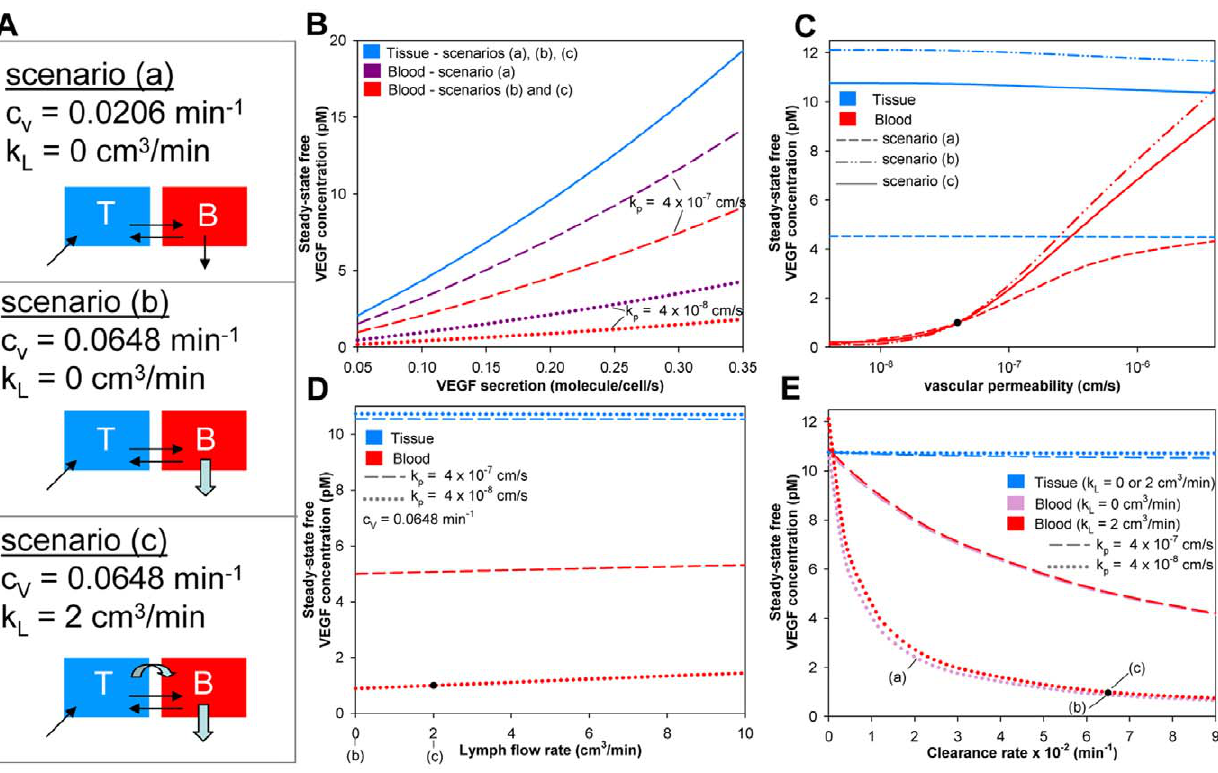
Figure 2. Effects of VEGF secretion, vascular permeability, lymph flow rate and clearance. A. Three scenarios are studied: scenario (a) our previous configuration from [9] (clearance rate c v =0.0206 min 2 1 ); scenario (b) new clearance c v =0.0648 min 2 1 in the absence of lymphatic drainage; scenario (c) introduction of the lymphatic drainage of VEGF k L =2 cm 3 /min (120 mL/hour [15]) with the new clearance c v =0.0648 min 2 1 . B. Effect of VEGF secretion. Free VEGF concentration in the tissue is illustrated in blue. The purple curve corresponds to scenario (a) and the red curves to scenarios (b) and (c) for the plasma VEGF concentration. We consider two permeability rates k p =4 6 10 2 8 cm/s (dotted curve) and 4 6 10 2 7 cm/s (dashed curve). C. Effect of vascular permeability to VEGF. Scenarios (a), (b) and (c) are represented as the dashed, dashed-dotted-dotted and solid curves respectively. The blue curve corresponds to the tissue while the red curve corresponds to the blood. D. Effect of lymph flow rate. We only consider scenarios (b) and (c) to look at the effect of adding the lymphatics to our model. We consider two permeability rates k p =4 6 10 2 8 cm/s (dotted curve) and 4 6 10 2 7 cm/s (dashed curve). The blue curve corresponds to the tissue while the red curve corresponds to the blood. E. Effect of clearance rate. We consider two permeability rates k p =4 6 10 2 8 cm/s (dotted curve) and 4 6 10 2 7 cm/s (dashed curve). The blue curve corresponds to the tissue. The pink curve corresponds to scenarios (a) and (b) and the red curve corresponds to the scenario (c) of Figure 2A for the plasma VEGF concentration.